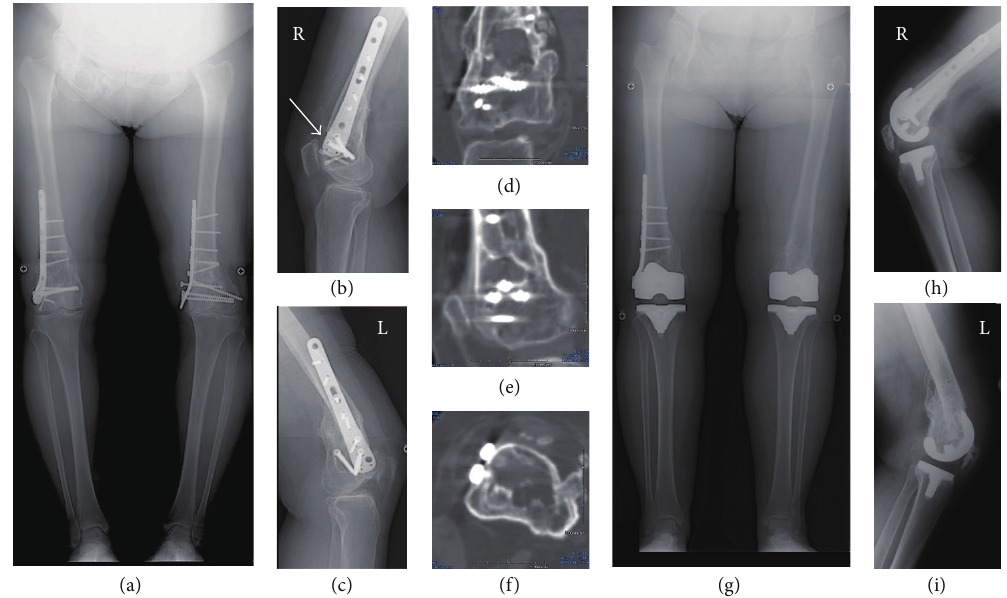
Figure 3: Case 2: preoperative anteroposterior standing radiograph (a) showed both malunited supracondylar fracture with hardware. Arrow on the lateral view of the right knee (b) indicates the defect of anterior cortex. Lateral view of the left knee (c) showed displaced distal femur. Coronal (d), sagittal (e), and axial (f) CT images of the right knee revealed the large cavity at the fracture site. Postoperative anteroposterior standing radiograph (g) demonstrated restored mechanical axis. Lateral view of the right knee (h) and the left knee (i) showed accurately placed